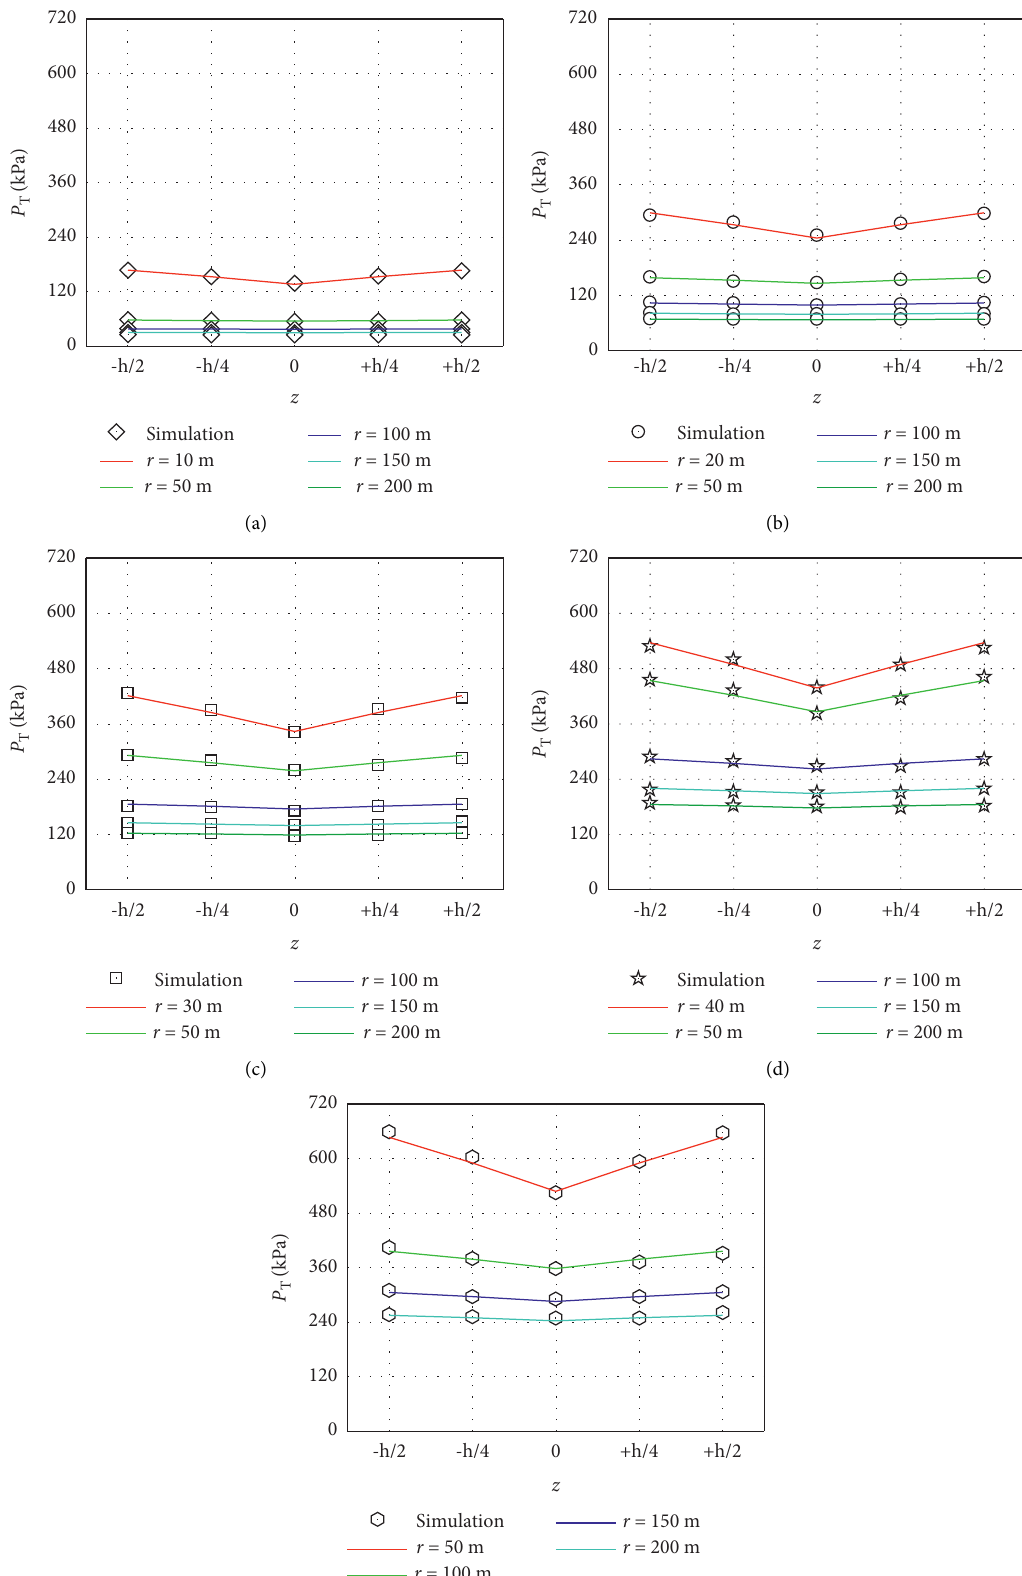
Figure 5: . Blast wave peak pressure transversal distribution. (a) r